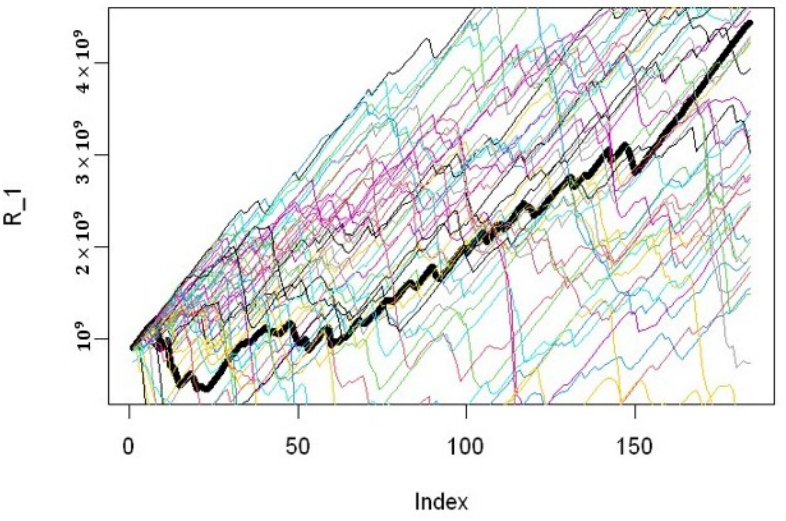
Figure 15. Plot of empirical risk process (bold line) and 50 simulations of the general compound Hawkes process in Group 1.